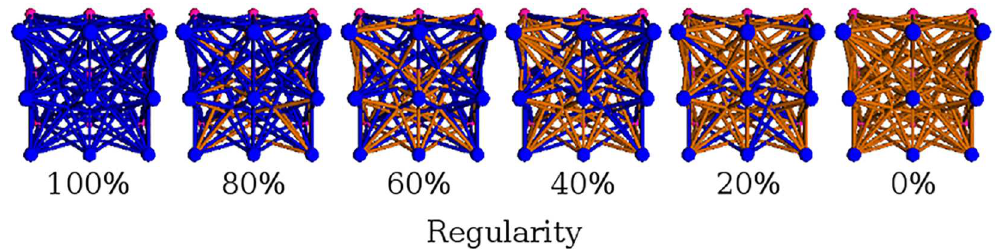
Fig 4. Adjusting the regularity of the target weights experiment. The regularityof the target weights experiment is scaled by adjustingthe percentage of repeatedlink weight values (blue) versus the amount of random link weight values (orange) in the target network. Completelyregular instanceshave 100% repeatedvalues, whilecompletely irregularinstanceshave randomvalues for all link weights. Adapted from [24].